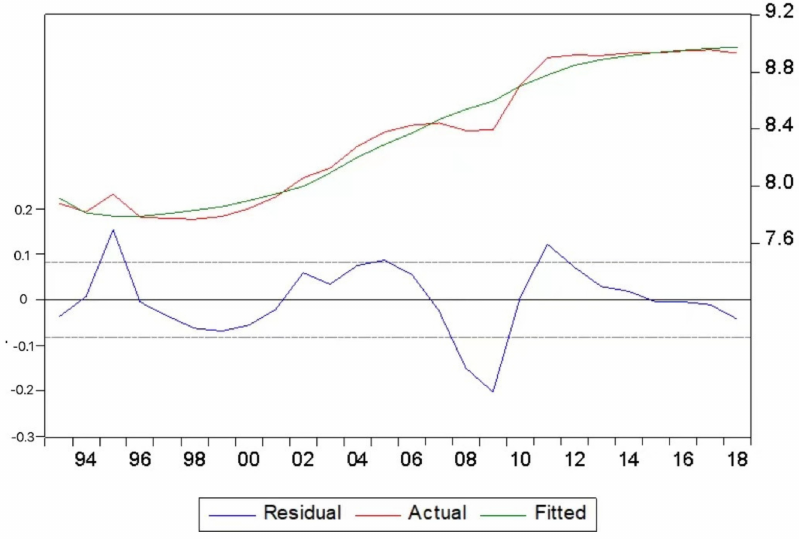
Figure 10. Model 3.